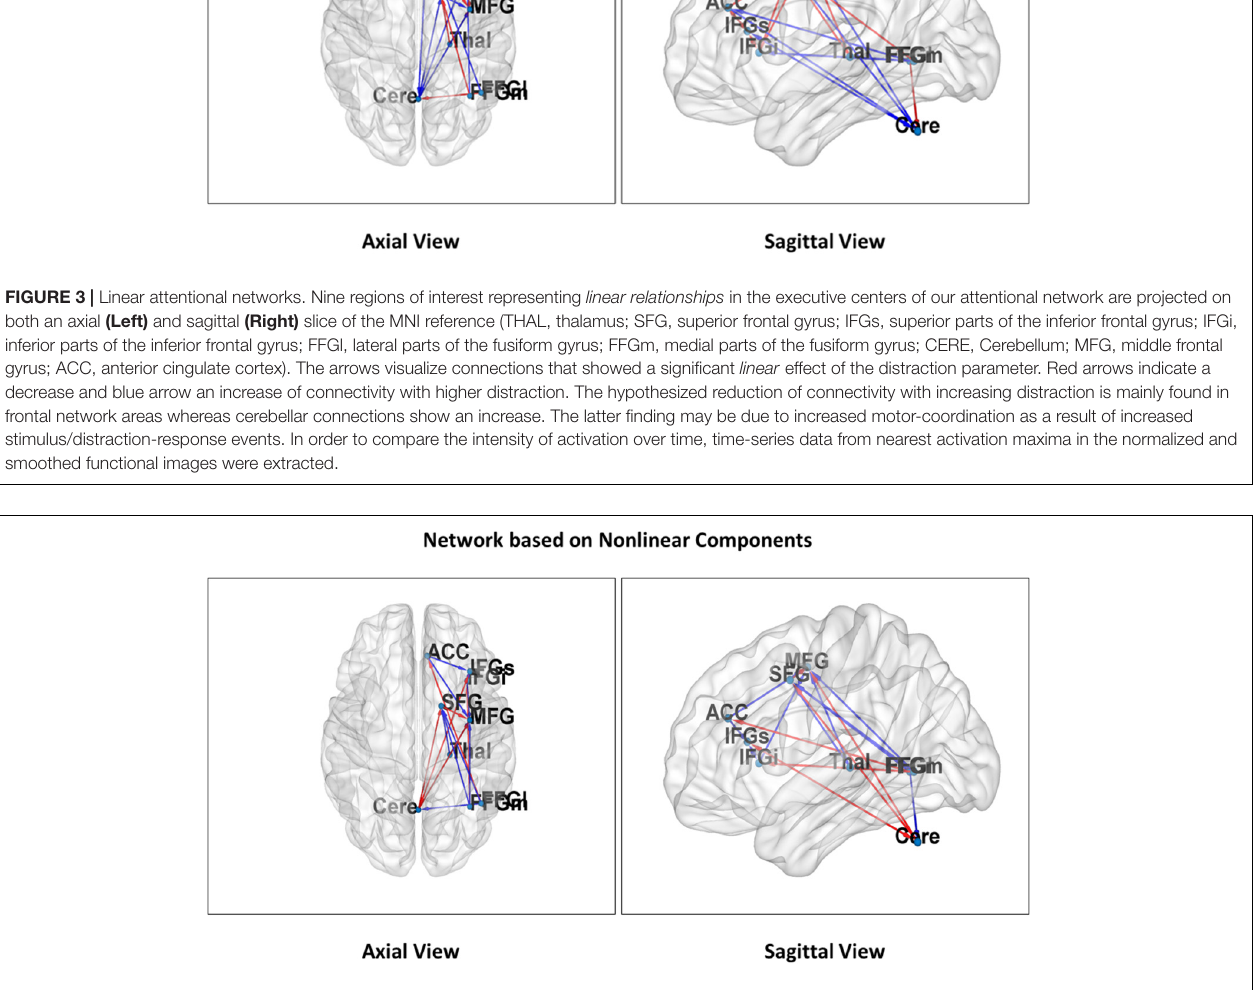
FIGURE 4 | Non-linear attentional networks. Nine regions of interest representing non-linear relationships in the attentional network are projected on both an axial (Left) and sagittal (Right) slice of the MNI reference. The arrows represent connections that showed a significant non-linear effect of the distraction parameter. Red arrows indicate a concave and blue arrow a convex relationship of connectivity with distraction. All connections are significant for both linear and non-linear coefficients and showed the opposite sign (see Figure 3 for